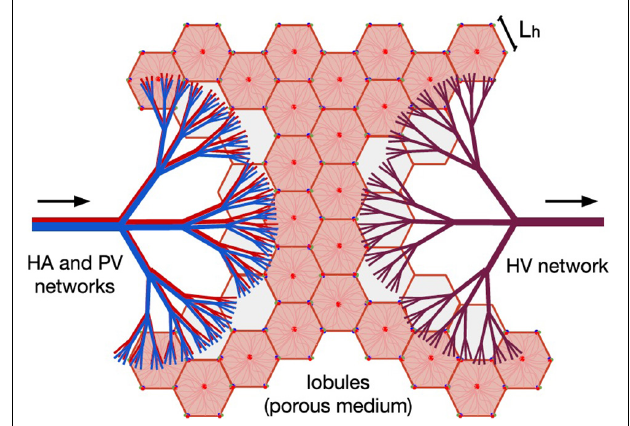
FIGURE 1 | Model of human liver circulation, adapted from Lorente et al. (2020). This model considers the hepatic vascular networks HA (in red), PV (in blue), and HV (in purple) as dendritic fluid networks, and each lobule as a component of a porous medium. Arrows indicate the direction of blood flow. Blood enters the liver through the HA and PV networks, then it is distributed among the existing lobules, and finally it is collected by the HV network responsible for draining the